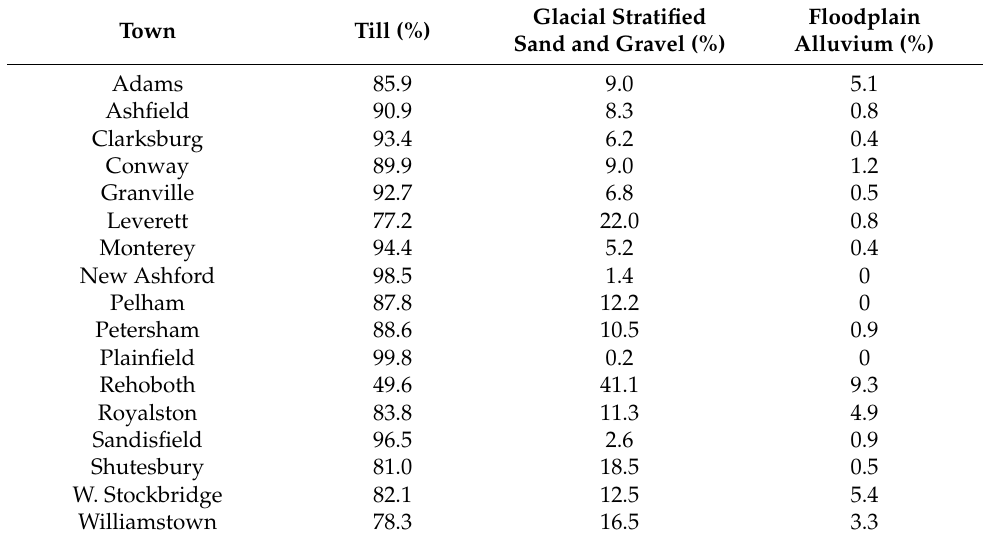
Table A2. Percent of town area covered by surficial